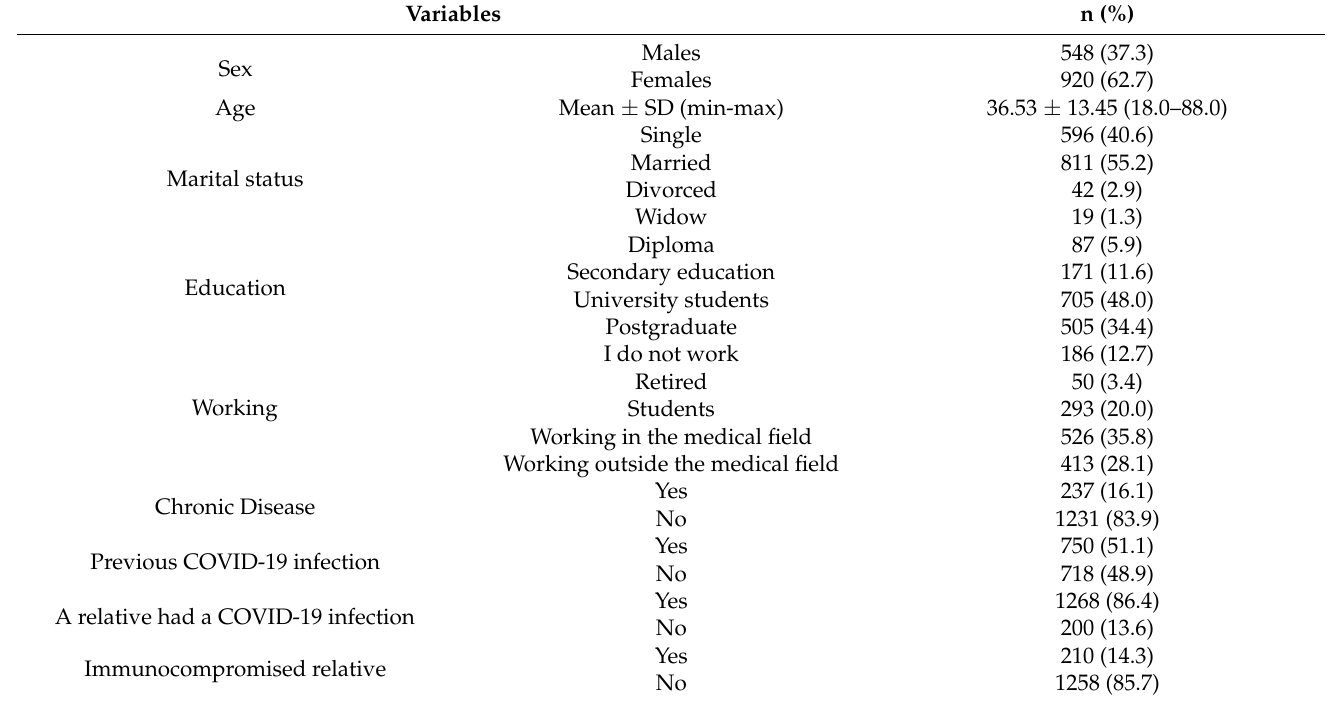
Table 1. Sociodemographic criteria and medical conditions, n = 1468. Variables n